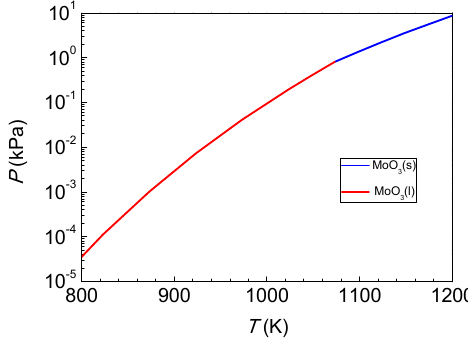
Figure 6. Dependence of the evaporation pressure P on the temperature T for MoO 3 .